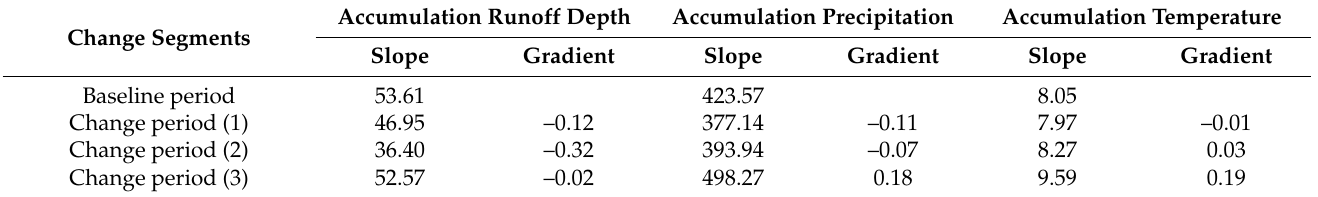
Table 5. Slope change rate of cumulative runoff precipitation and air temperature.